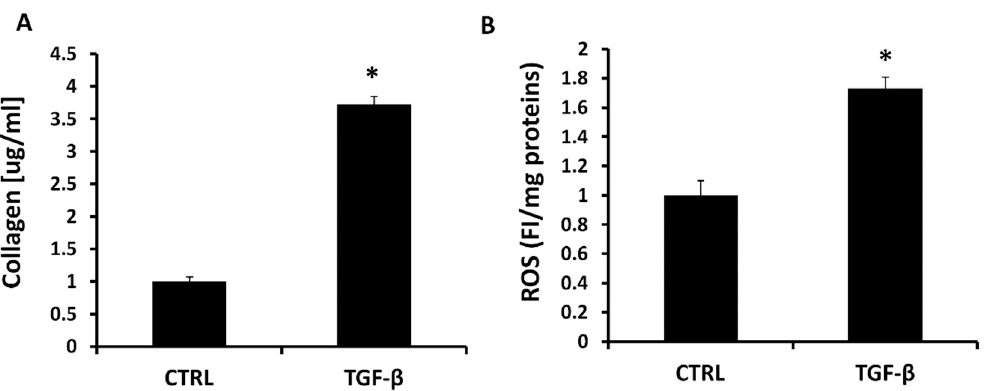
Figure 3 . ( A ) Soluble collagen in LX2 cells activated with TGF- β 5 ng for 24 h. Soluble collagen measurement are expressed as μ g/mL. Values represent the means ± SD of three experiments performed in triplicate. * p < 0.05, significant result vs. untreated LX2 cells. ( B ) Intracellular oxidants in LX2 cells activated with TGF- β 5ng for 1 h. Results are mean ± SD, * p < 0.05 vs. CTRL.